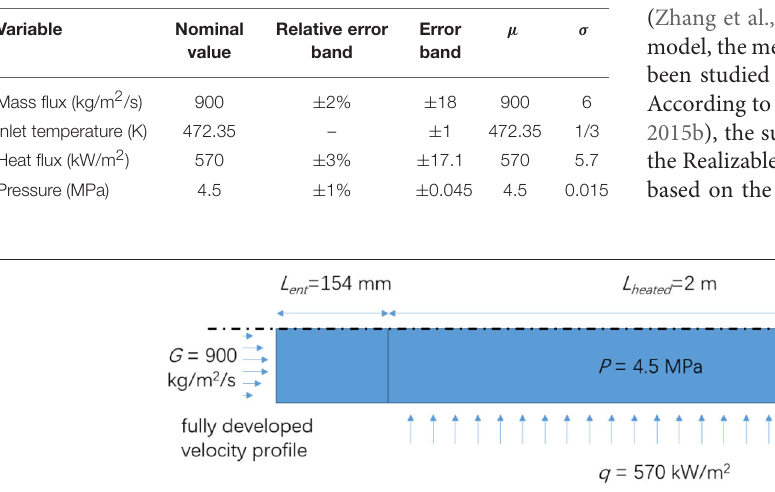
TABLE 1 | Statistical parameters for the measured input variables.